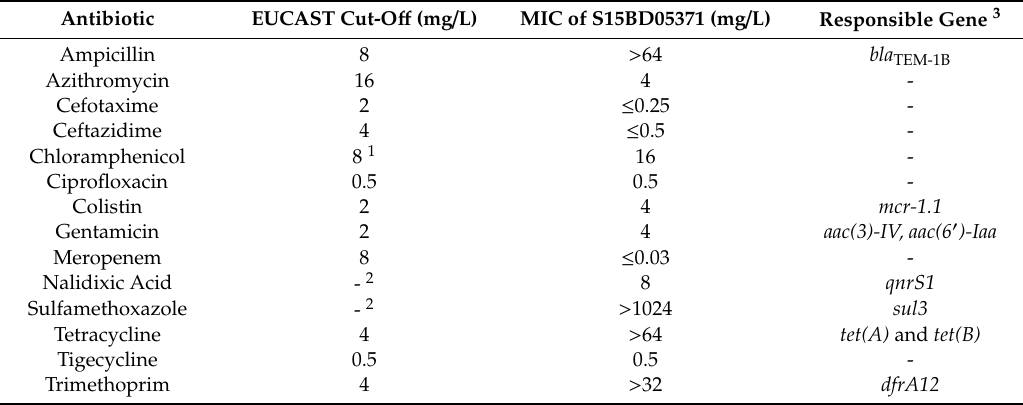
Table 4. Minimum inhibitory concentration (MIC) of Salmonella isolate S15BD05371 and the responsible genes for the antibiotics where an MIC higher than the EUCAST cut-o ff was observed